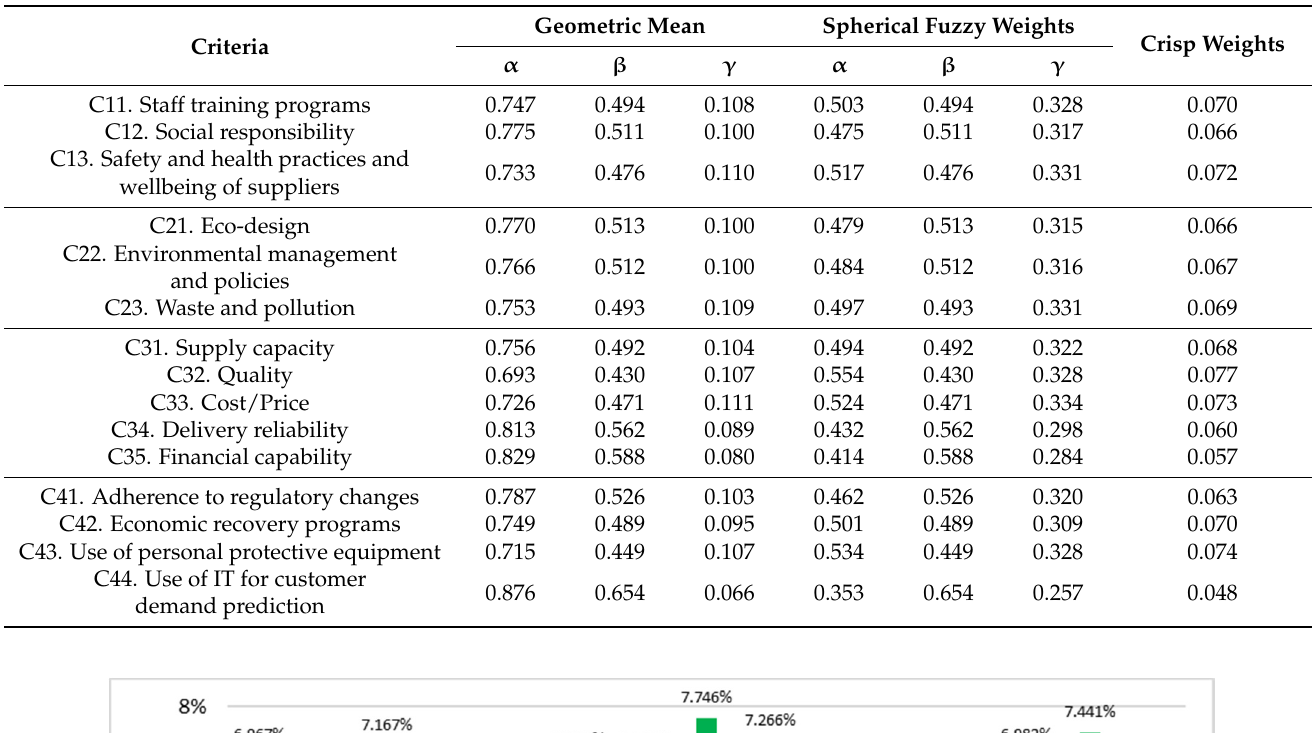
Table 11. Spherical fuzzy weights and crisp weights 15 criteria of SF-AHP.